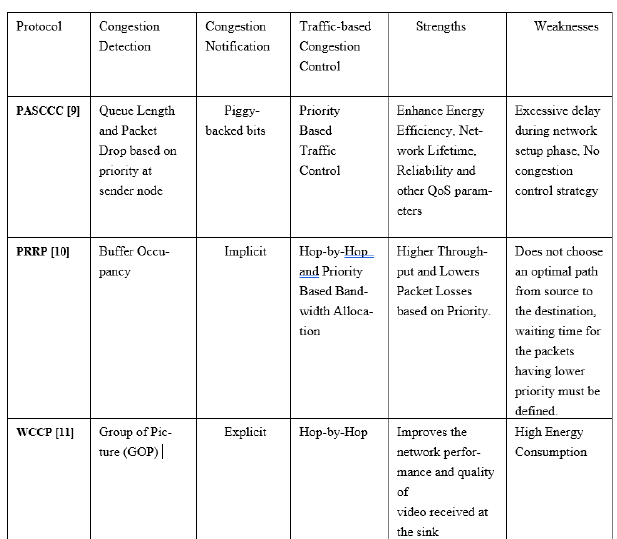
Table 1. Traffic-based control based congestion control